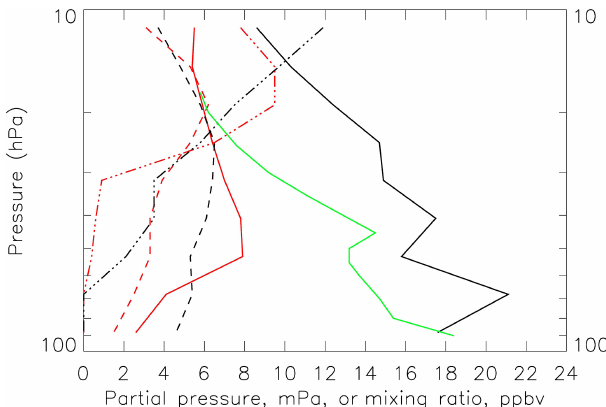
Figure 3. V6 Level 2 species profiles for 59.5 ◦ S, 31 ◦ E (red) and 54.9 ◦ S, 119.4 ◦ E (black) on 26 October 1978, and from an ozonesonde at Syowa (69 ◦ S, 40 ◦ E – green) on 3 September 1978. Ozone (solid) has units of millipascals (mPa), while HNO 3 (dashed) and NO 2 (dot-dashed) have units of